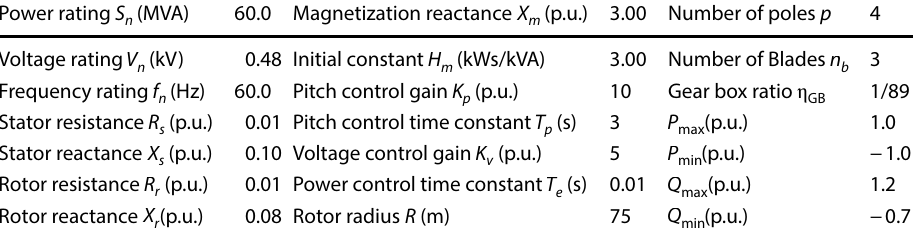
Table 15 Data of doubly-fed induction machine (DFIG) wind turbine [38]